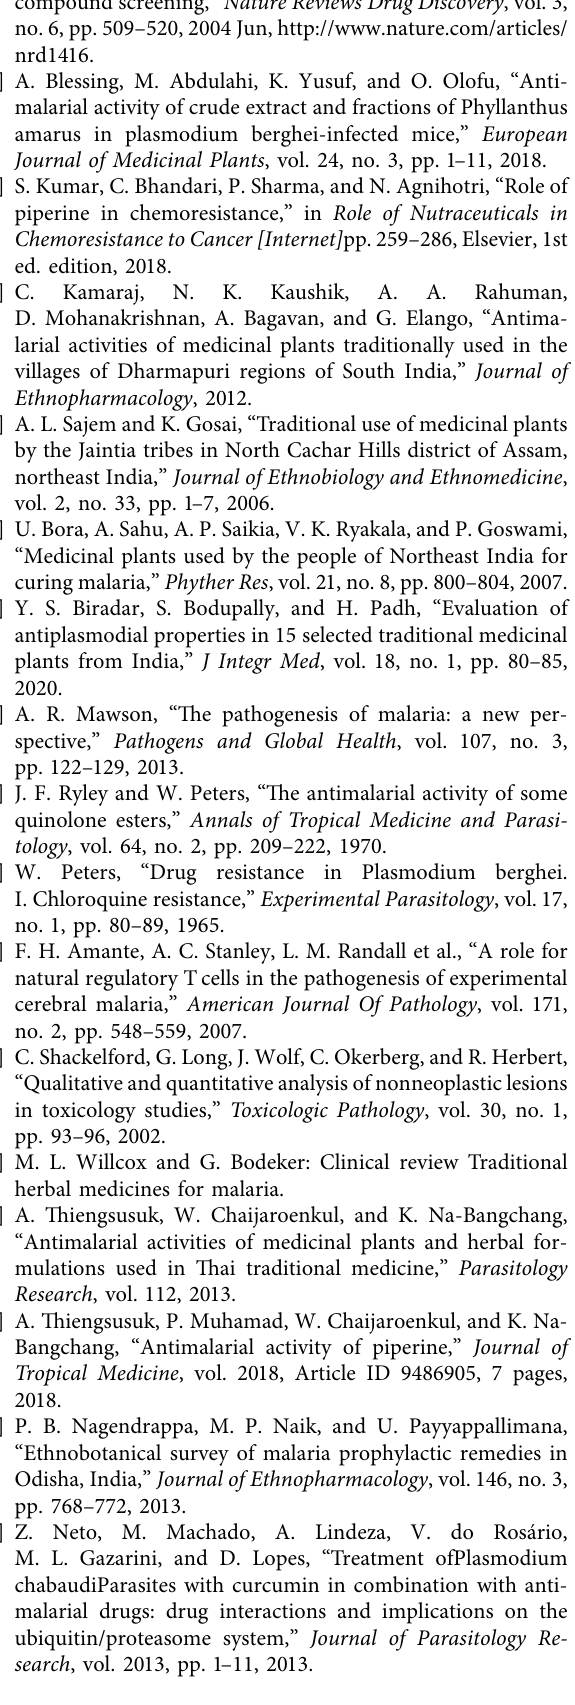
Figure S1: histopathology of lung, Figure S2: histopathology of liver, Figure S3: histopathology of spleen, and Figure S4: histopathology of kidney. ( Supplementary Materials